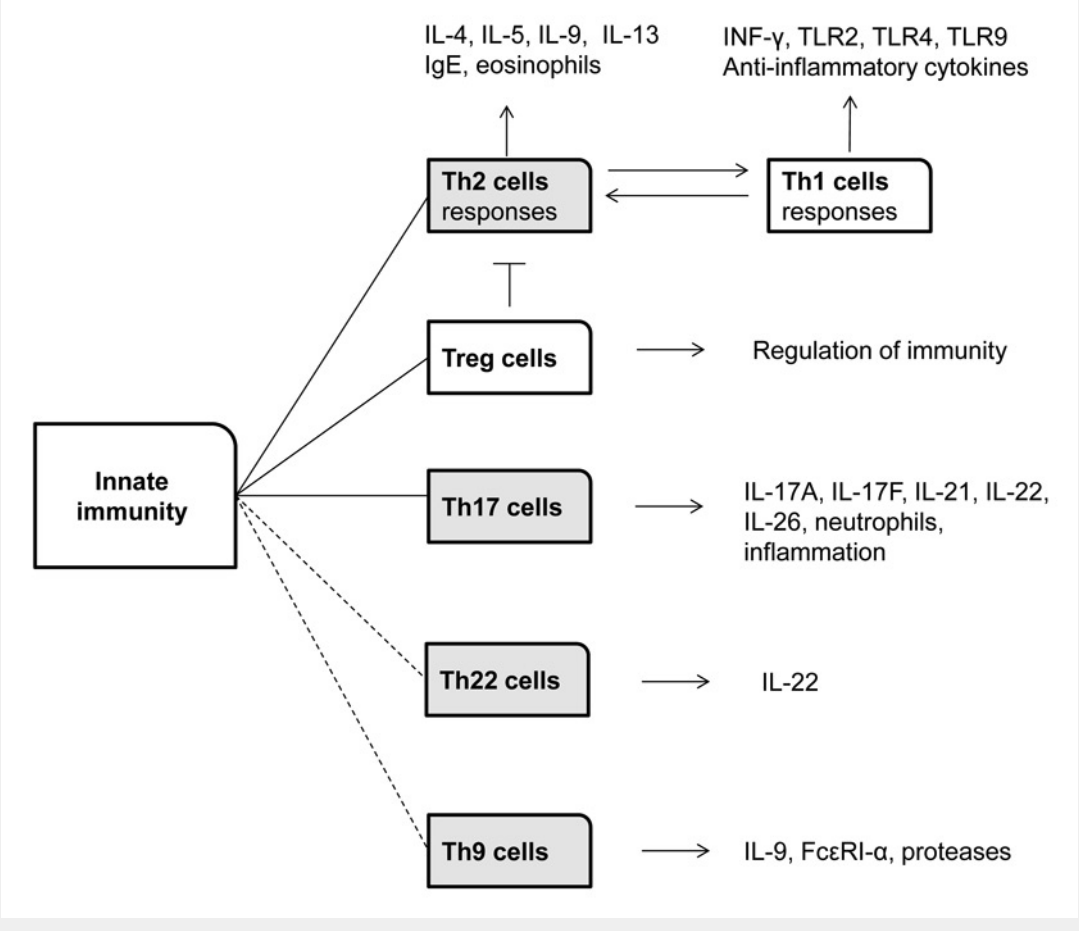
Figure 2 Contributions of different immune system cells and molecules in pathogenesis of childhood asthma. The solid lines describe the T helper cells that have been associated with asthma in humans whereas the broken lines represent asthma studies that have been conducted in animal models and their role in human is yet to be determined. Th2 responses lead to production of IL-4, IL-5, IL-9, IL-13 which are associated with increased levels of IgE and eosinophils leading to asthma. Th1 responses include anti-inflammatory cytokine INF-γ, and early infant immune system development (possibly by TLR-2, TLR-4, TLR-9). Th1 responses render protection against asthma. Tregs inhibit the production of Th2 cells and Th2 cytokines, and are regulators of immune system self-tolerance, prevent autoimmunity and suppress allergies. Th17 cells produce pro-inflammatory cytokines IL-17A, IL-17F, IL-21, IL-22, IL-26 and are associated with an increased number of neutrophils and amount of inflammation. Th22 cells, which produce pro-inflammatory IL-22, are believed to play an important role in asthma pathogenesis. Th9 cells produce IL-9, which stimulates expression of FcεRI-α and mast cell proteases. Th9 cells are also believed to play an important role in asthma